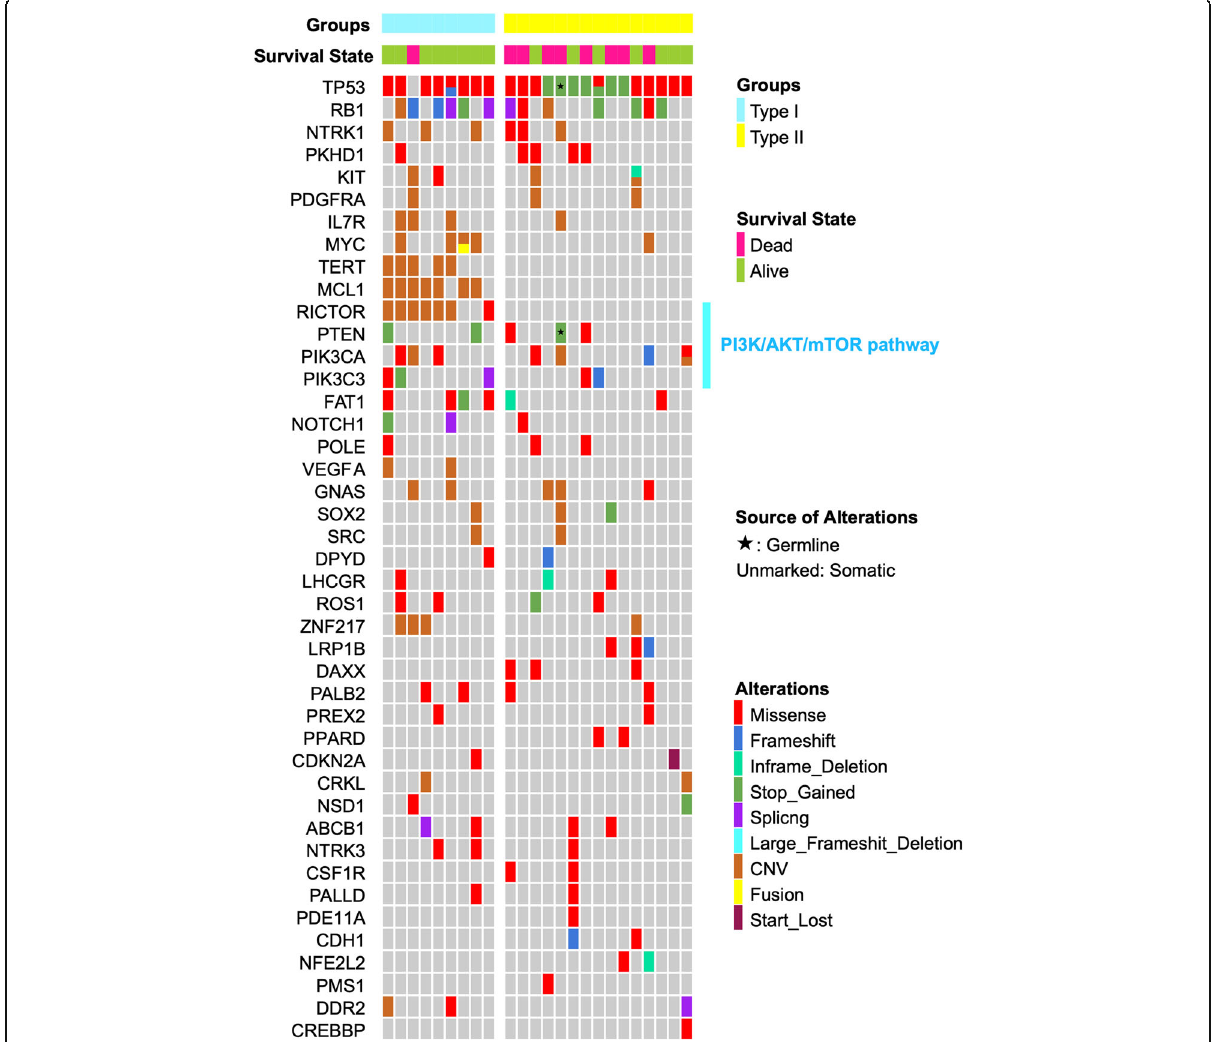
Fig. 5 Genetic alterations among two types of LCNEC and LCNEC-null. Type I ( n = 9) is characterized by high CNV alteration, especially at TERT, RICTOR and MCL1. Type II ( n = 15) have a high correlation with TP53 stop_gained and poor